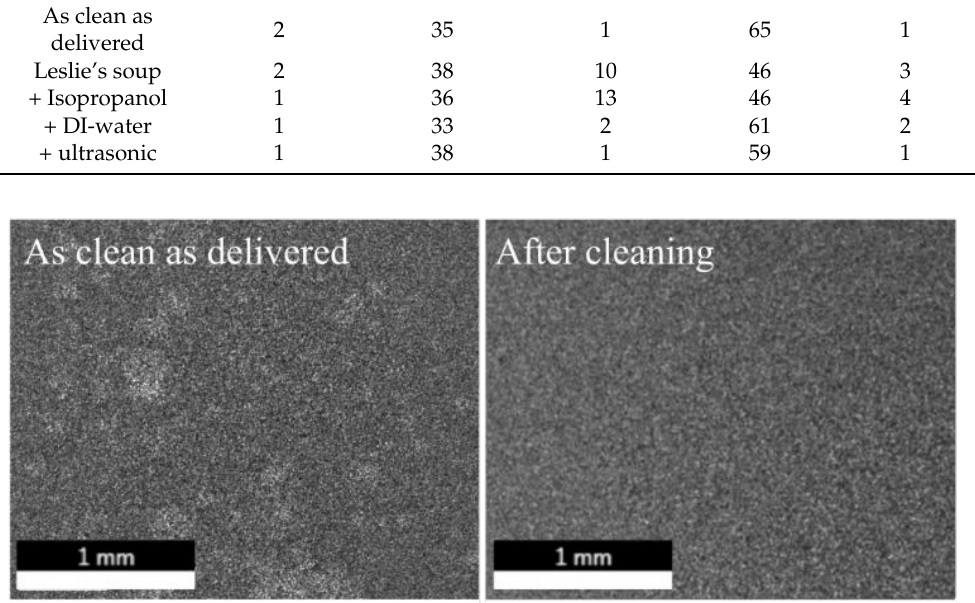
Table 1. Elemental analysis of the ceramic surfaces after the single process steps of the cleaning procedure. Treatment